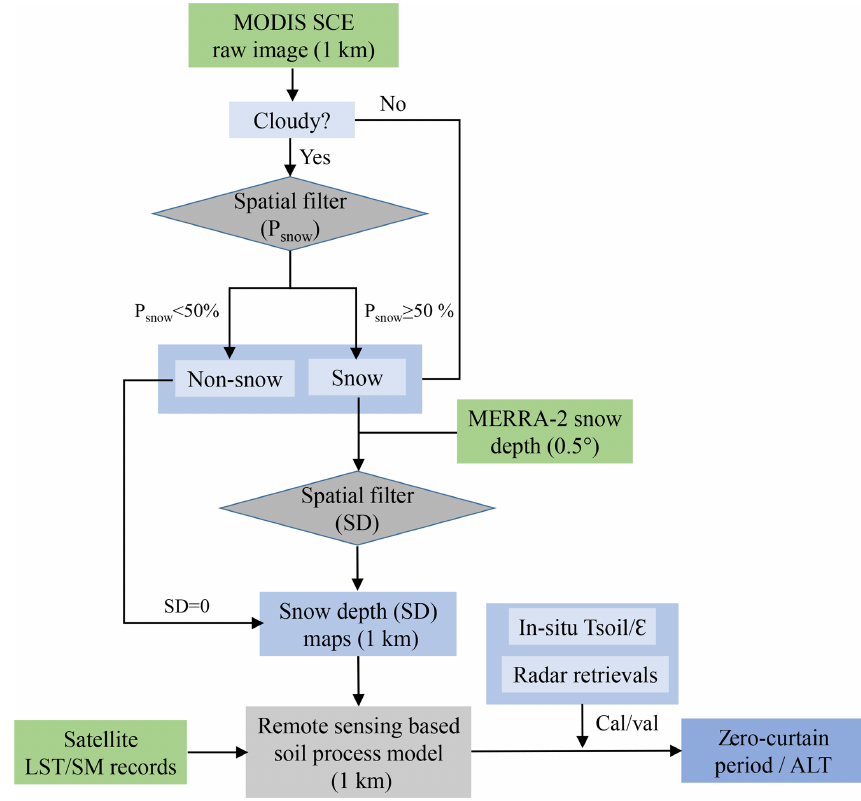
Figure 1. Flow diagram describing the snow data processing and soil modeling procedure. A spatial filter was used to predict the snow occurrence probability for MODIS cloud-contaminated pixels. Based on the cloud-free MODIS SCE imagery, the snow depth of each snow- covered 1km pixel was estimated from the snow depth of the neighboring MERRA-2 grid cells with weights predicted using another spatial filter. The downscaled 1km snow depth data were then used to drive a remote-sensing-based soil process model to simulate the zero-curtain period and ALT. Both the snow data processing and soil modeling were carried out at an 8-day time